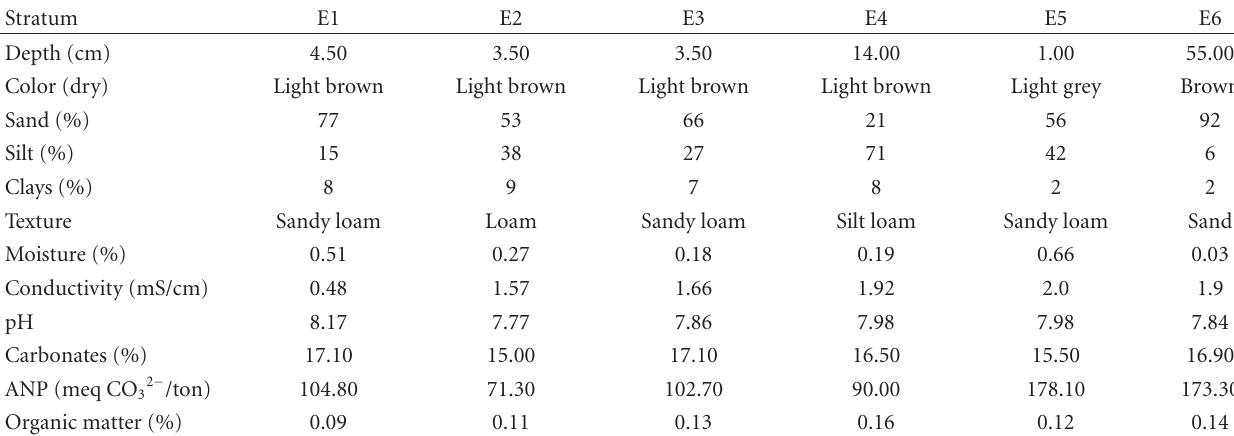
Table 1: Certain physical and chemical characteristics of the strata E1 to E6.